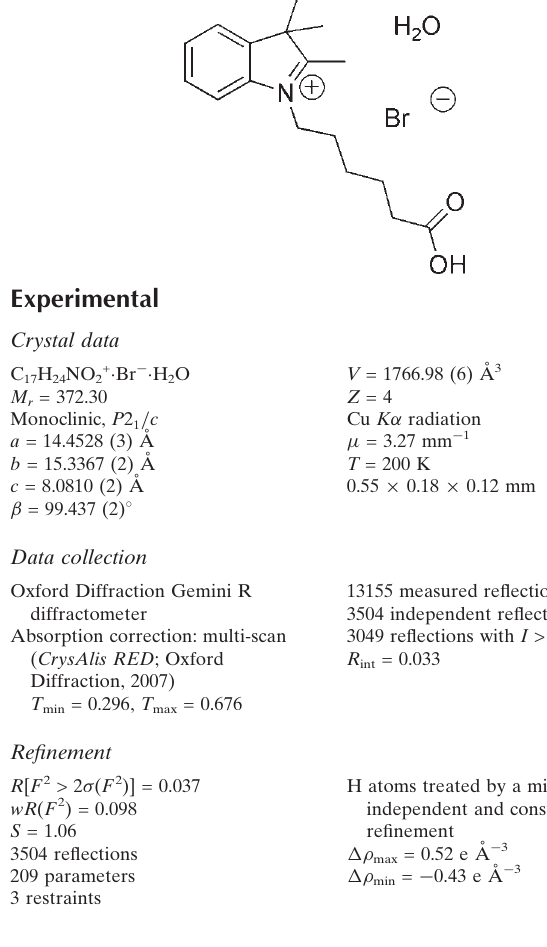
Absorption correction: multi-scan ( CrysAlis RED ; Oxford